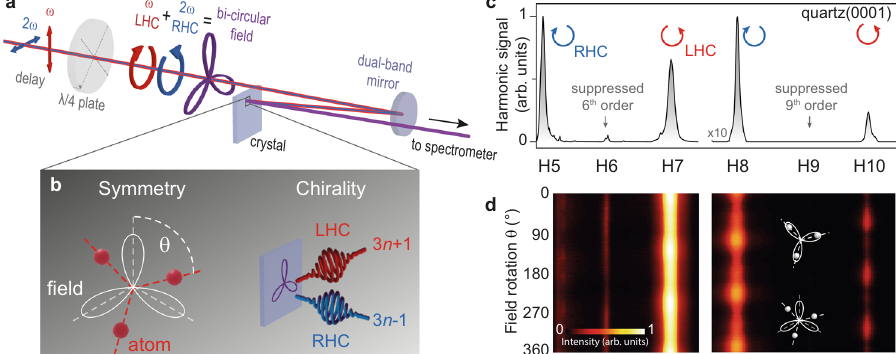
Fig. 1 Chiral high-harmonic generation in solids. a Two-color laser pulses (frequencies marked ω and 2 ω ) with perpendicular polarization and adjustable phase delay can be converted to circularly-polarized fi elds with opposite helicity using a dichroic quarter-wave plate with the fast-optical axis set to 45° relative to the laser polarization. The superposition yields a bi-circular fi eld with a threefold rotation symmetry. The ellipticity and the orientation of the fi eld (see angle θ in ( b )) depend on the quarter-wave plate rotation and the phase delay between the two spectral fi eld components, respectively. The emitted harmonic radiation is collected with an extreme-ultraviolet spectrometer. LHC left-handed circular, RHC right-handed circular. b Schematic depiction of the symmetry and chirality probing principle using a bi-circular fi eld for HHG in solids. c High-harmonic spectra from quartz(0001) (harmonic orders label with H5 – H10), showing suppression of every third harmonic order. The blue and red arrows indicate the helicity of the harmonics. d Spectrogram for quartz (0001) as a function of the threefold fi eld rotation angle θ (see also pictograms), exhibiting a threefold